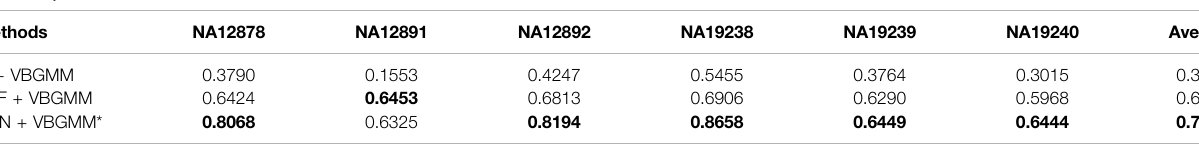
TABLE 1 | F1-score on six real blood datasets.